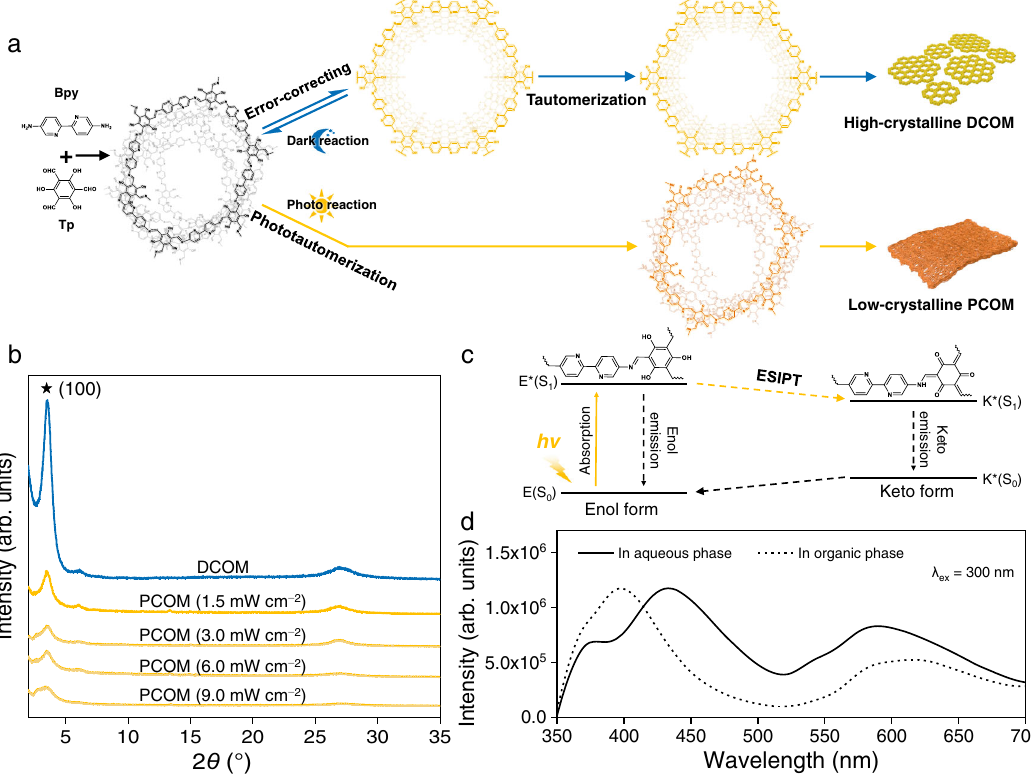
Fig. 2 Photo-tailored reactive-crystallization of Schiff-base COM. a Synthetic route (blue) of COM by dark reaction (DCOM) and synthetic route (yellow) of COM by photo reaction (PCOM) using reactive monomers of 2,2 ′ -bipyridine-5,5 ′ -diamine (Bpy) and 1,3,5-triformylphloroglucinol (Tp). b XRD patterns of the DCOM (blue) and PCOMs (yellow) formed under varied irradiation intensity ranging from 1.5 to 9.0 mW cm – 2 . c Schematic illustration of the excited-state intramolecular proton transfer (ESIPT) process of enol-imine linkage. d Steady-state photoluminescence emission spectra of the initial amorphous material dispersed in either aqueous phase (solid lines) or organic phase (dashed lines). These samples were excited at 300